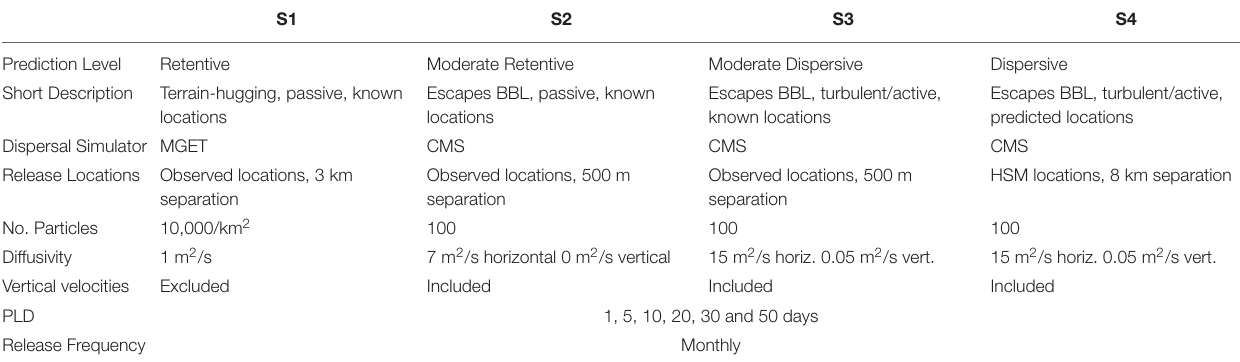
TABLE 1 | A parameterization summary of each of the four scenarios (S1–S4) simulated in this